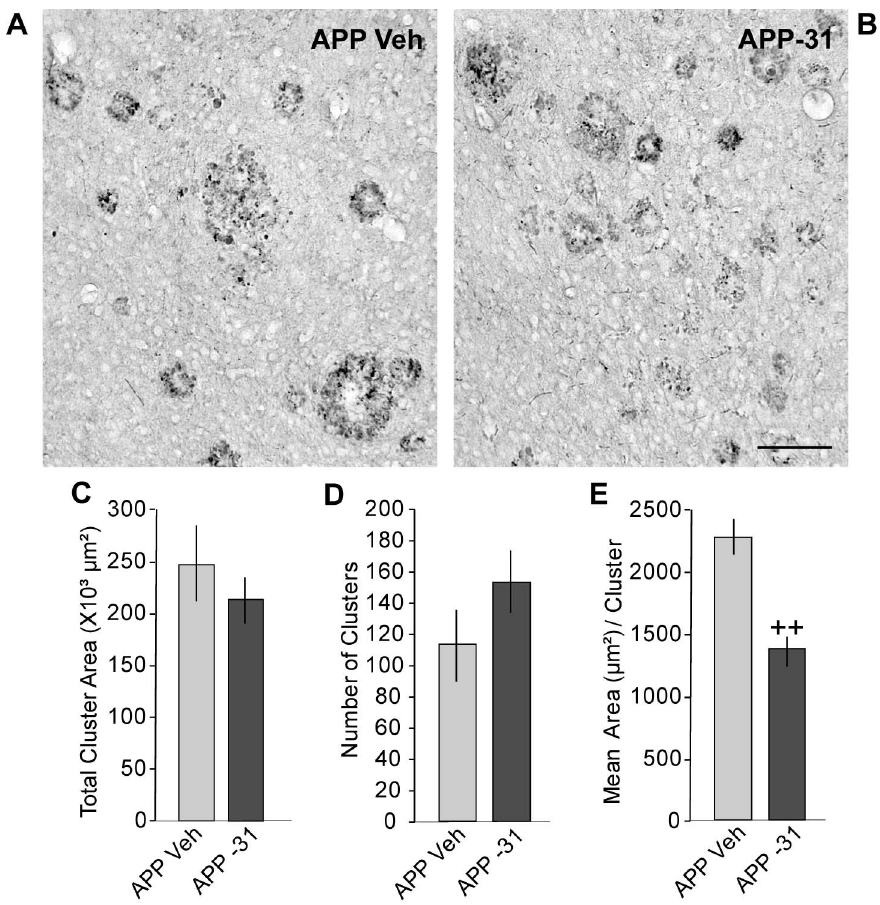
Figure 8. LM11A-31 prevents cholinergic dystrophic neurites in cortex of late-stage APP L/S mice. Representative photomicrographs show clusters of cholinergic dystrophic neurites in the cortex of APP L/S (APP) Veh ( A ) and APP-31 ( B ) mice. Scale bar in B=50 m m. Quantitative analysis showed that LM11A-31 did not significantly affect the total area ( C ) or number ( D ) of clusters but did decrease the size or mean area per cluster ( E ). Statistical significance was determined using a two-tailed Student’s t-test. ++ p # 0.01 vs. APP Veh.